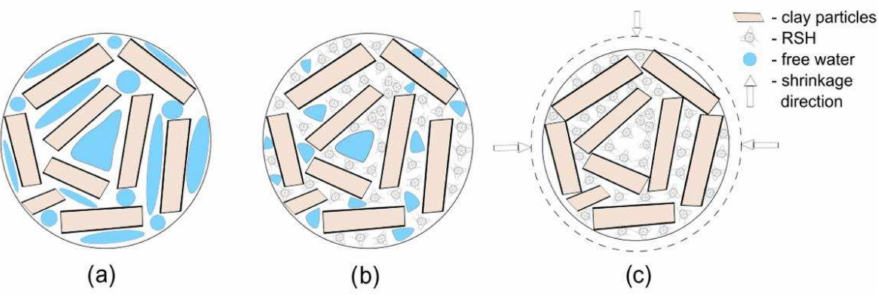
Figure 5. Schematic representation of the clay composite structure: ( a ) without RSH, ( b ) with RSH, and ( c ) shrinkage behavior of clay with